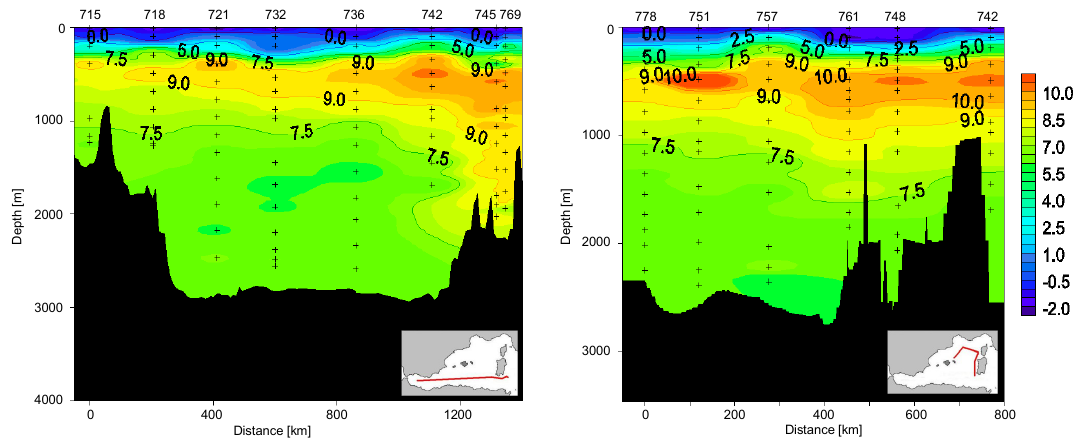
Fig. 8. WMed δ 3 He sections (%) of Poseidon 234, 1997, extended southern section left, northern curved section right. Numbers on top are station numbers, sections cf. inset